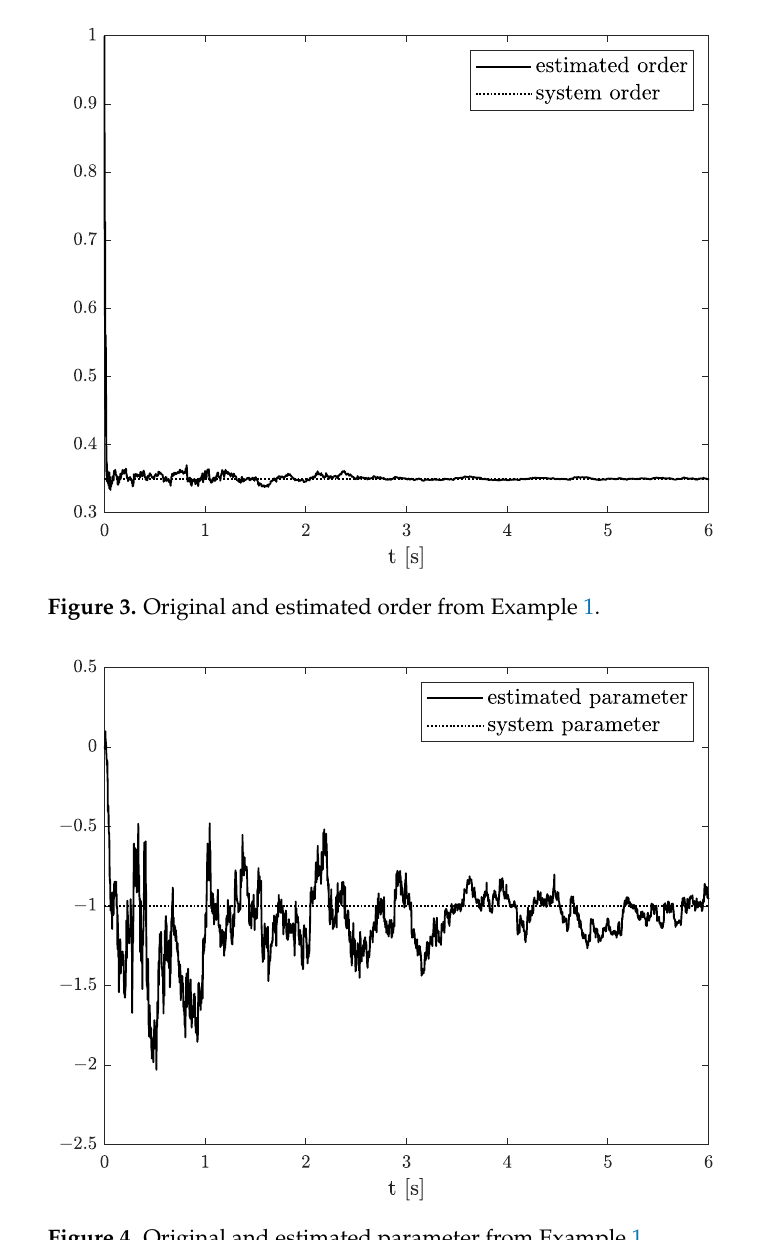
Figure 4. Original and estimated parameter from Example